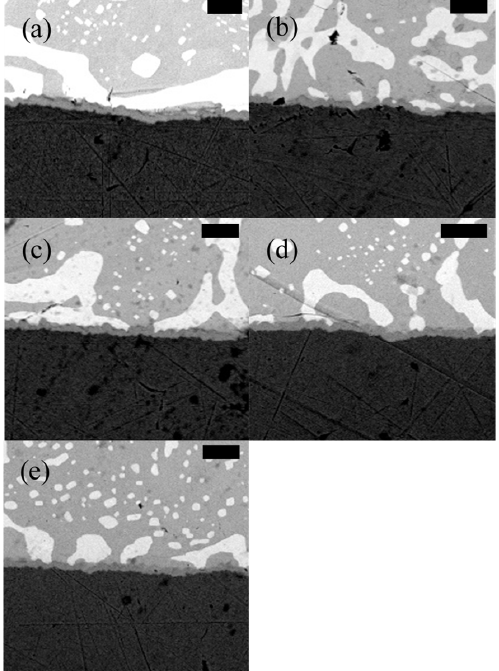
Figure 12. SEM images of LT 51 reflowed with ( a ) a peak temperature of 165 °C and 45 s TAL, ( b ) peak temperature of 165 °C and 90 s TAL, ( c ) peak temperature of 177 °C and 45 s TAL, ( d ) peak temperature of 177 °C and 90 s TAL and ( e ) peak temperature of 190 °C and 90 s TAL. The scale bar is 4 µm in all images.